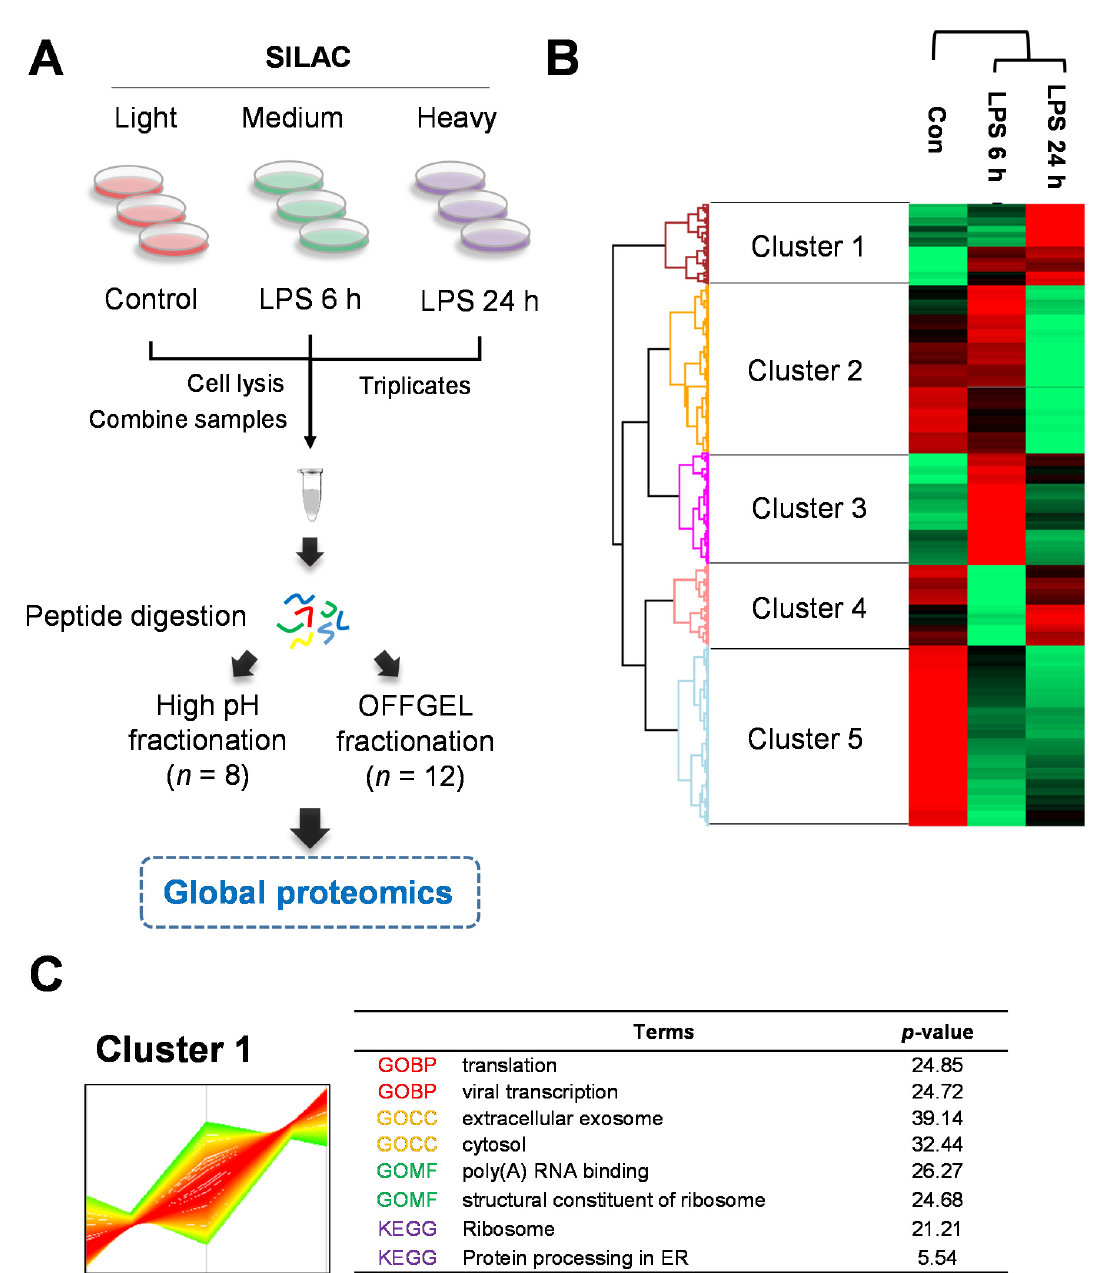
Figure 2. Experimental scheme of comparative proteome analysis in sepsis-induced liver dysfunction (SILD) in human hepatoma cells. ( A ) For the global proteomic approach, SILAC-labeled HepG2 cells were prepared with 1 μ g/mL LPS treatment for 6 h (“medium”, K4R6) and 24 h (“heavy”, K8R10) as well as without LPS treatment as the control group (“light”, K0R0). Peptide were subjected to fractionation using two methods: high-pH phase fractionation and the OFF-GEL fraction. All experiments were performed in biological triplicates. ( B ) The global proteomics analysis of significantly differentially expressed proteins (DEPs) by volcano plot of LPS treatment for the 6 h and 24 h group. ( C ) Protein expression dynamic clusters based on global protein expression patterns at each stage of sepsis-induced liver dysfunction (SILD). The functional gene ontology (GO) and KEGG were shown at cluster 1.